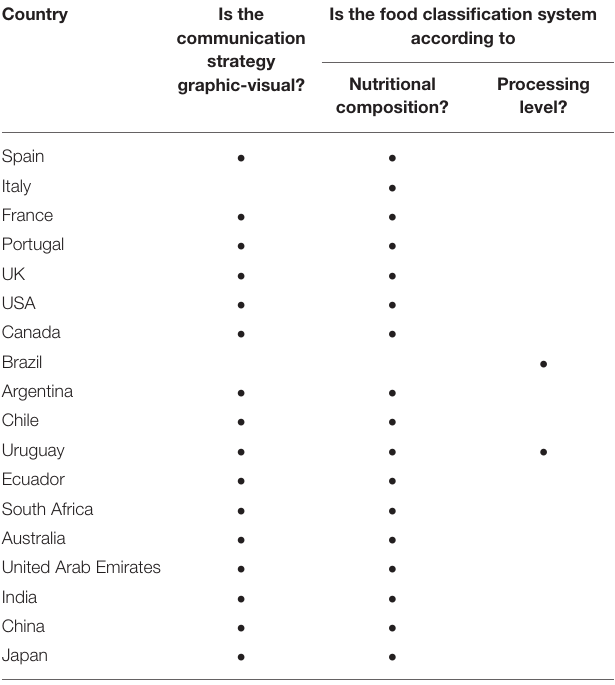
TABLE 1 | FBDG communication strategies relating to food classification.